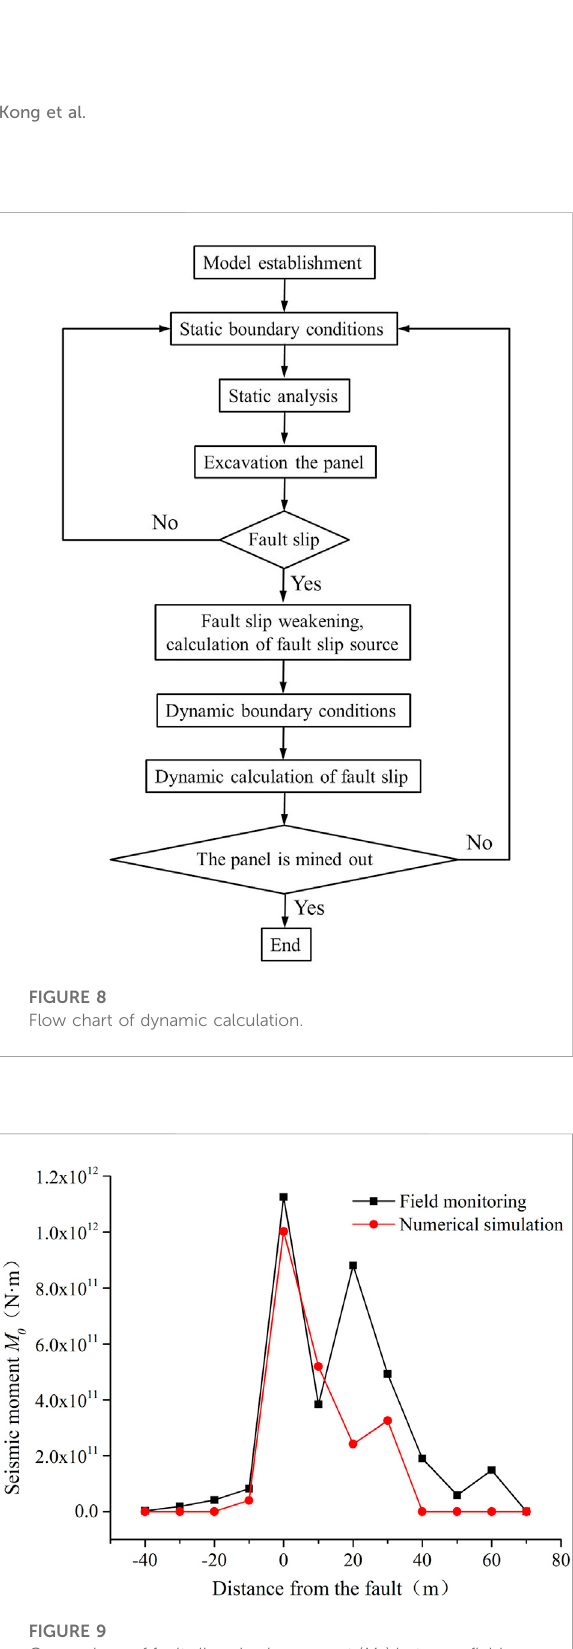
FIGURE 9 Comparison of fault slip seismic moment ( M 0 ) between fi eld monitoring and numerical